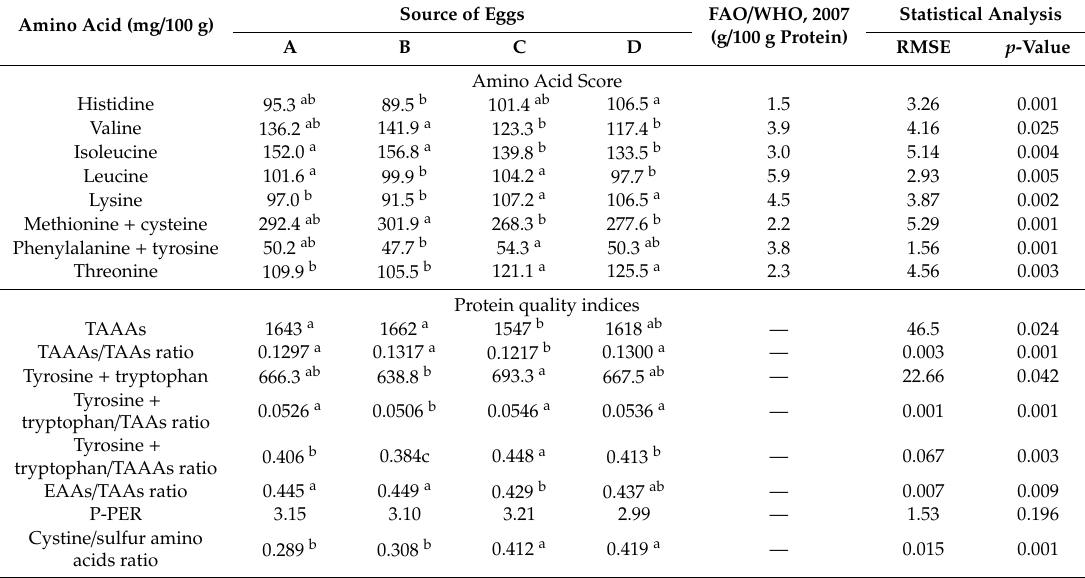
Table 5. Amino acids score (%), aromatic amino acids, essential amino acids to the total amino acid ratio. Antioxidant amino acids of the whole edible egg parts (albumen + yolk) of di ff erent sources compared to standard Food and Agriculture Organization (FAO) / World Health Organization (WHO) [22] values. Amino Acid (mg / 100 g)